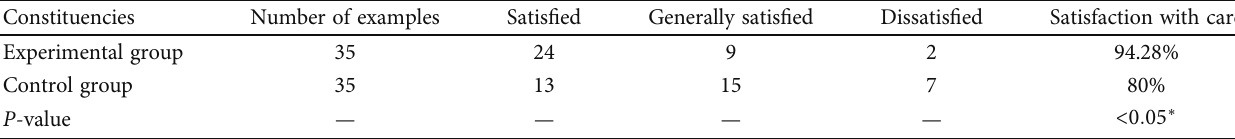
Table 4: Comparison of nursing satisfaction between the two groups ( N